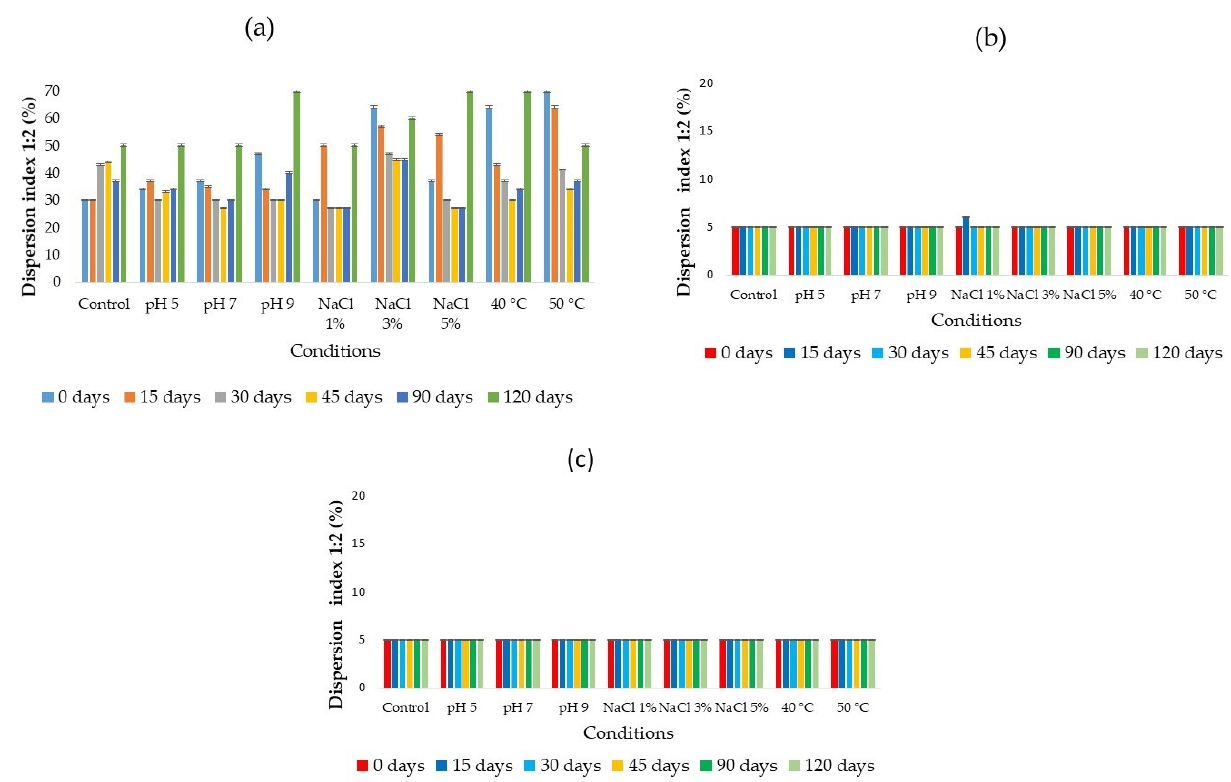
Figure 8. Motor oil dispersion index of the biosurfactant produced by Candida sphaerica, submitted to different preservation treatments, ( a ) 0.2% potassium sorbate, ( b ) fluent steam + 0.2% potassium sorbate, ( c ) fractionated tyndallization, and stored under different conditions over a period of 120 days. Biosurfactant-to-oil proportion = 1:2 ( v / v ).